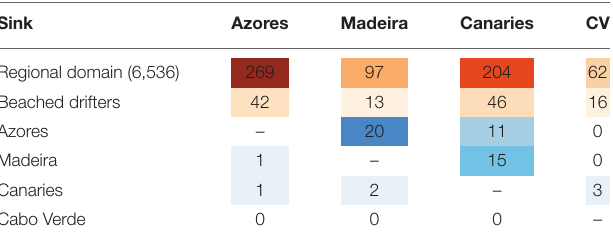
TABLE 2 | Overview of the GDP drifters intercepting the Macaronesia archipelagos (top rows) and drifter connectivity between archipelagos (bottom rows).